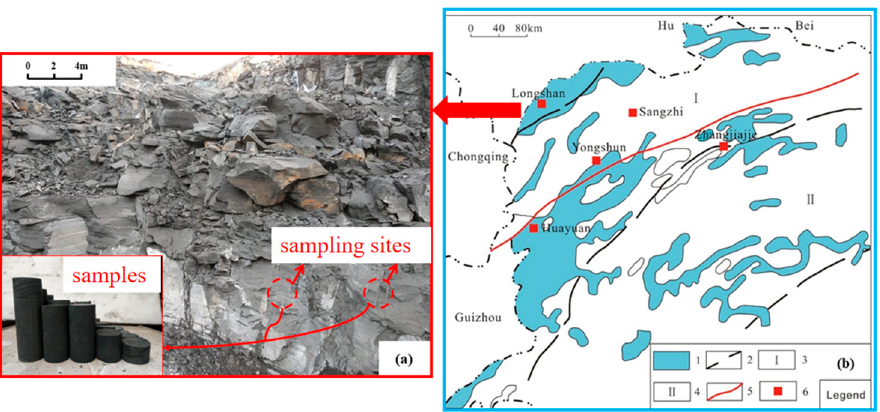
Figure 1. A map of the regional structure and shale outcrop of the Lower Cambrian Niutitang Formation in northwestern Hunan Province, modified after Cao et al., 2018 [28]. 1: Outcrop distribution area; 2: Stratigraphic boundary; 3: Northwestern Hunan area; 4: Xuefeng District, central Hunan; 5: Deep fault; 6: Sampling sites. Table 2. Contents of mineral components in shale samples.